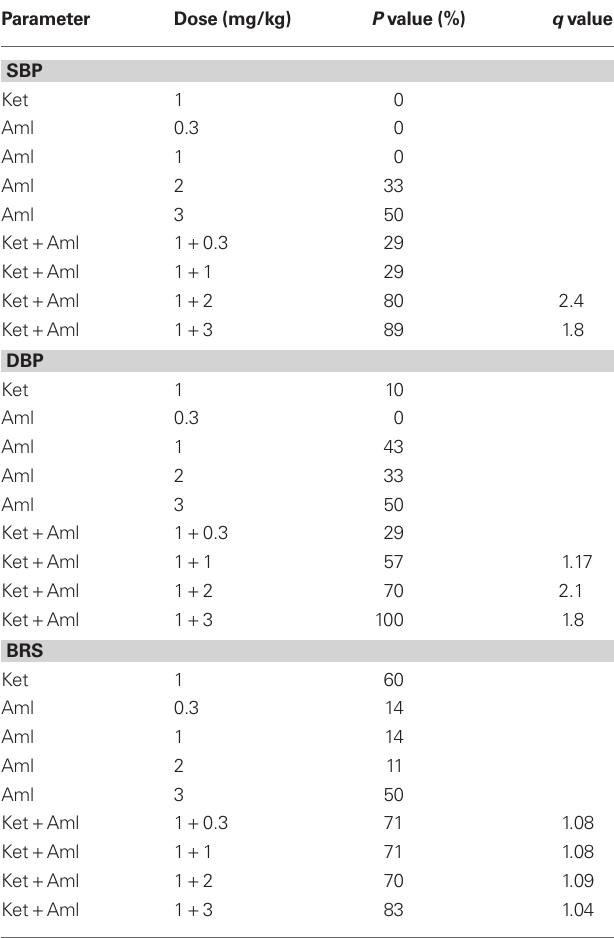
Table 2 | The probability sum test in SHr-SP treated with ketanserin (Ket) and amlodipine (Aml) Alone or in